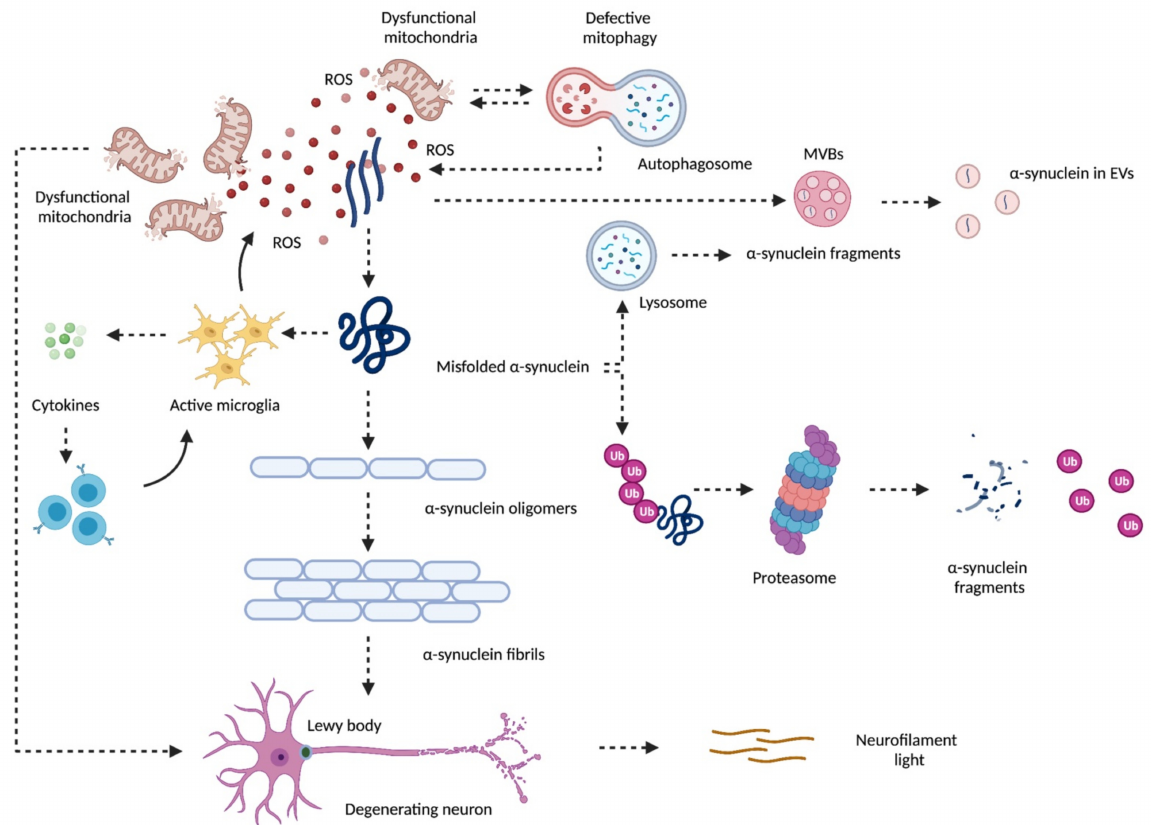
Figure 1. Schematic representation of the contribution of defective mitochondrial quality control and mitochondrial dysfunction to neurodegeneration in Parkinson’s disease. Mitochondrial dysfunction arising from defective quality control pathways (e.g., mitophagy) ignites the production of reactive oxygen species (ROS) and activates the α -synuclein aggregation cascade. Before reaching its pathological conformation, α -synuclein can be degraded along the endosomal pathway, packaged within multivesicular bodies (MVBs), and released as extracellular vesicles (EVs). In the setting of overwhelmed ubiquitin-proteasome and autophagy-lysosomal systems, misfolded α -synuclein is not efficiently cleared and aggregates into soluble oligomers. These structures generate insoluble fibrils that compose the core of intraneuronal Lewy bodies and Lewy neurites, thereby promoting neurodegeneration. The accrual of misfolded α -synuclein activates microglial cells that attract cells of peripheral immunity within the central nervous system via cytokine release. This instigates a vicious circle resulting in persistent microglial activation which amplifies mitochondrial dysfunction and induces further neuronal damage. Created with BioRender.com, accessed on 24 September